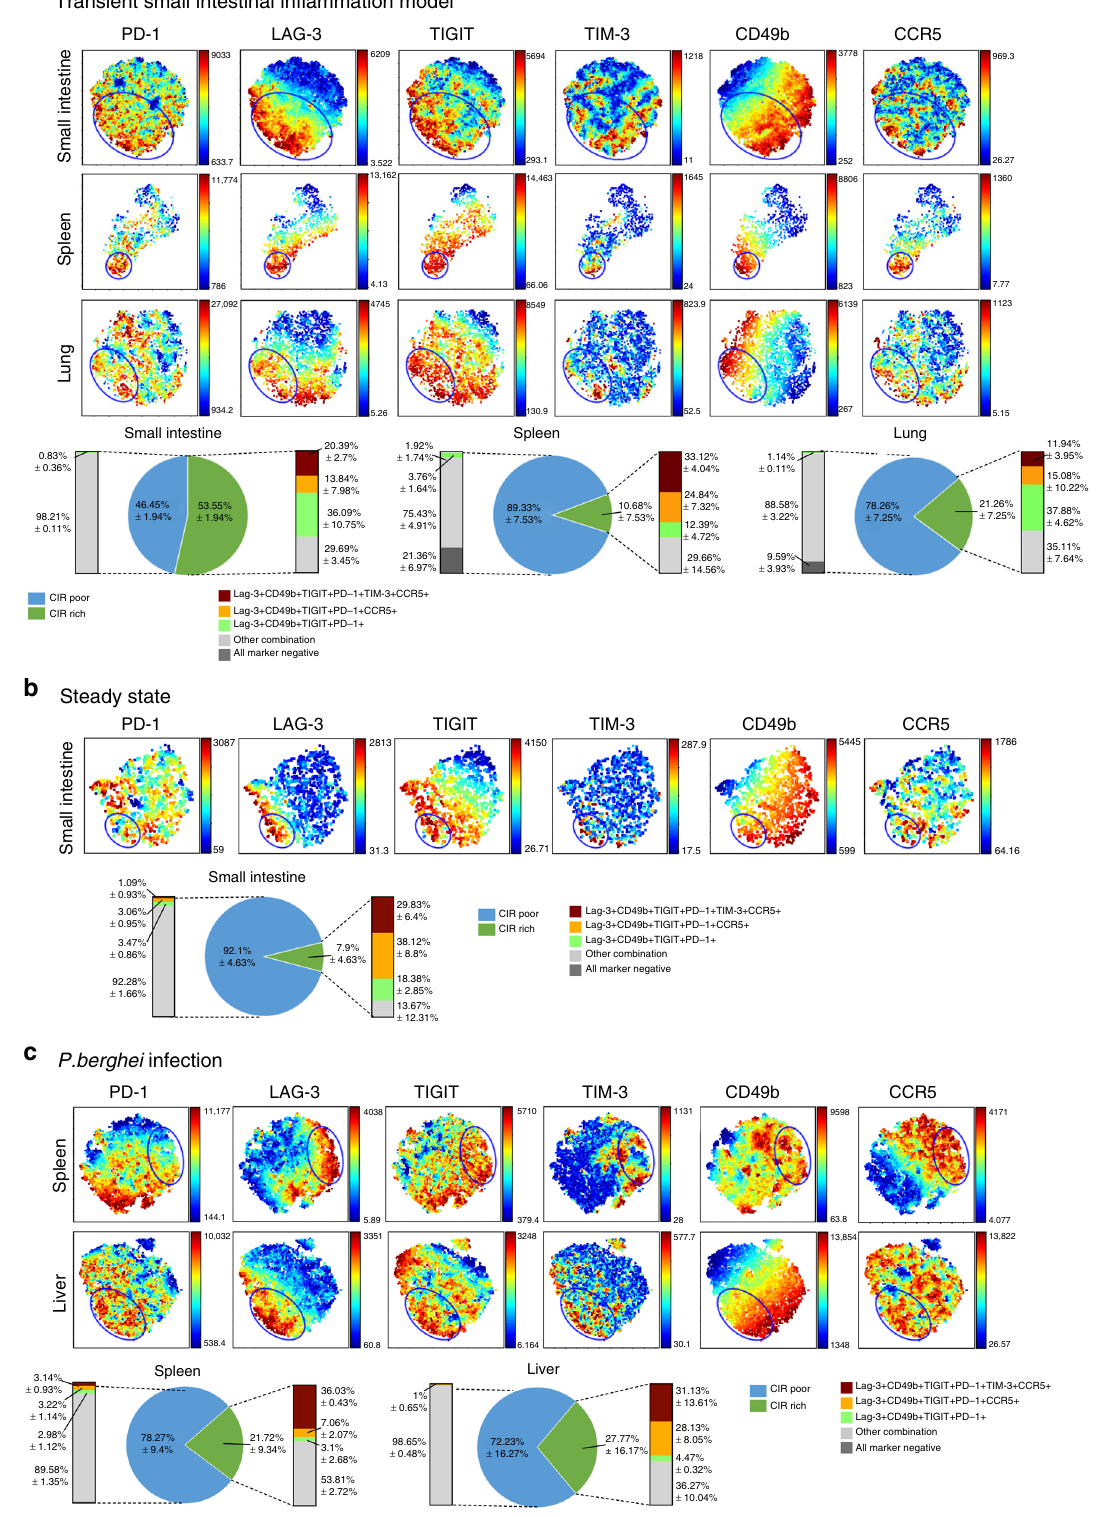
Fig. 3 CIR identify regulatory IL-10-producing CD4 + T cells. vi SNE analysis of IL-10 pos Foxp3 neg CD4 + T cells. Clustering is based on MFI of PD-1, LAG-3, TIGIT, TIM-3, CD49b, and CCR5. Blue circle indicates co-inhibitory receptor rich (CIR rich) region. a Analysis of cells from small intestine, spleen, and lung of aCD3-treated IL-10 eGFP Foxp3 mRFP double reporter mice ( n = 4). Data are representative of two independent experiments. b Analysis of untreated IL- 10 eGFP Foxp3 mRFP double reporter mice ( n = 3). Data are representative of three independent experiments. c Analysis of P. berghei infected IL-10 eGFP Foxp3 mRFP double reporter mice ( n = 3). Data are representative of two independent